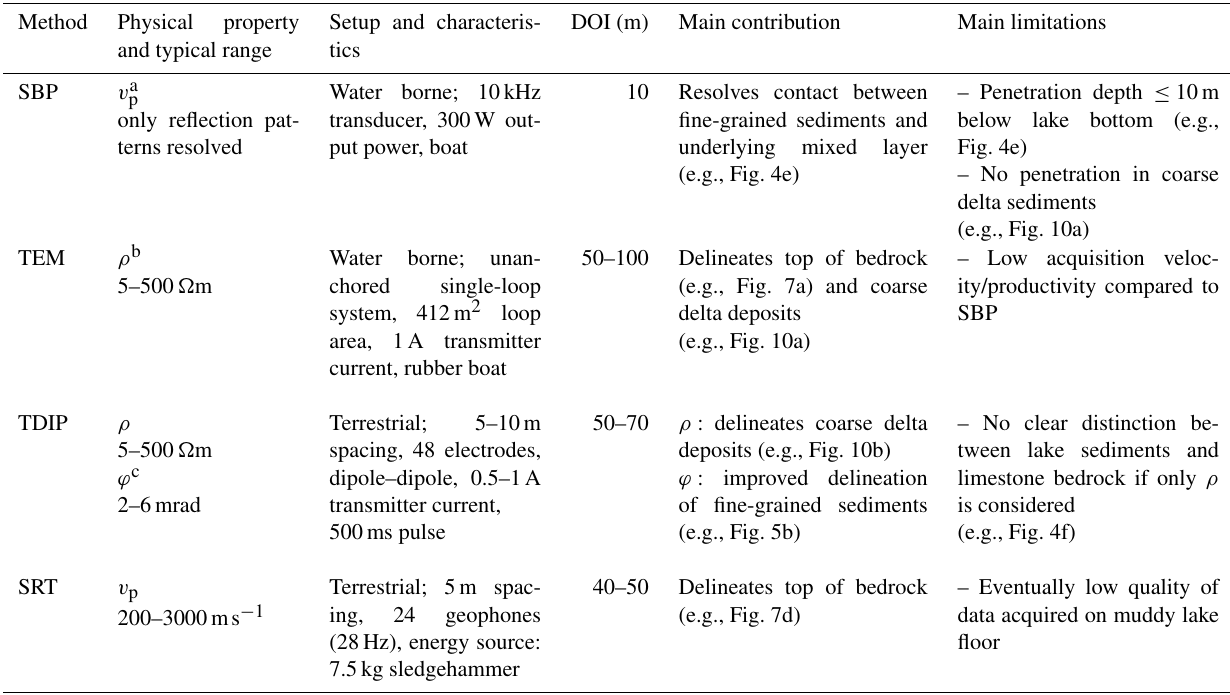
Table 2. Methods used to image the sub-bottom structure of the studied lakes. Summary of physical properties resolved, typical parameter ranges in the study area, and setup and characteristics of the measurements. Typical depths of investigations (DOIs) depend on the specific instrumental setup used; main contributions and limitations mostly refer to the present study and the specific geological